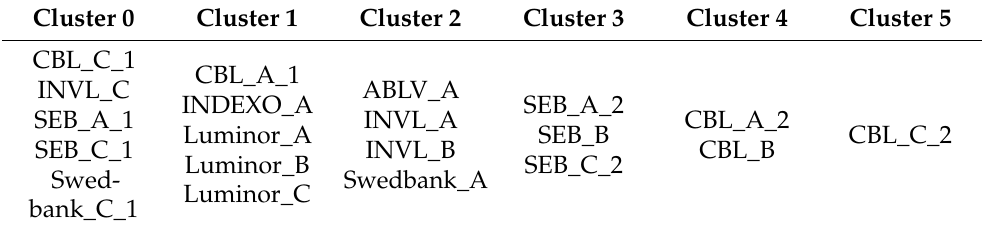
Table 3. The combination of pension fund clusters usually occurred in the filtered dataset when six clusters were used. This combination of pension funds will be examined further using statistical